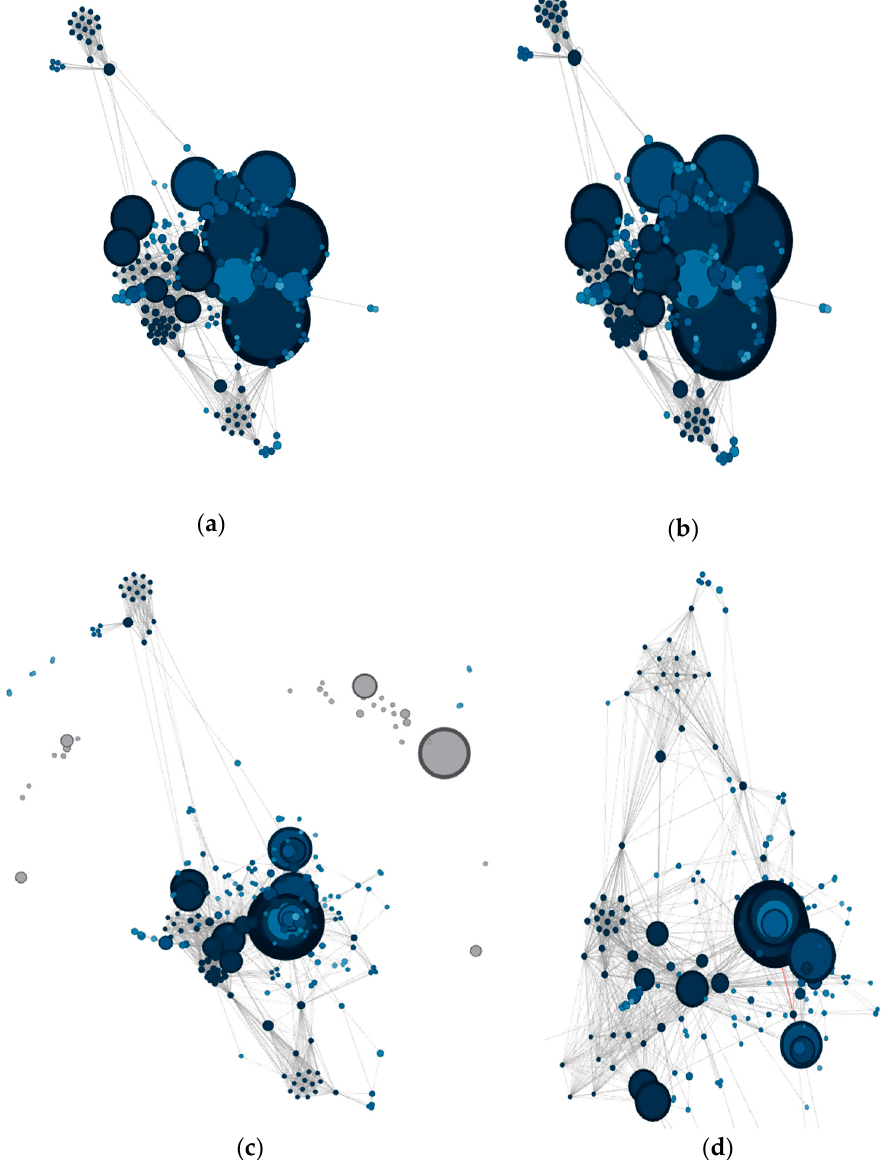
Figure 7. Community network visualization applying different resolutions for community visualization. ( a ) Community network using a resolution of 1.0 points; ( b ) Community network using a resolution of 0.1 points; ( c ) Community network using a resolution of 0.01 points; ( d ) Community network using a resolution of 0.001 points.